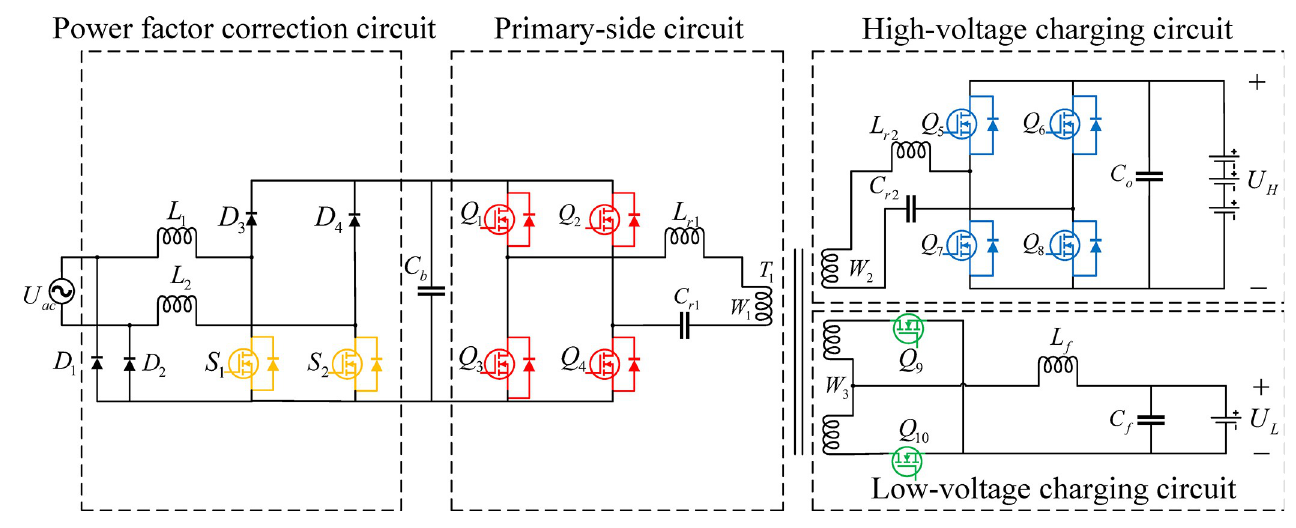
Fig 2. The topological structure of the dual-output on-board charging